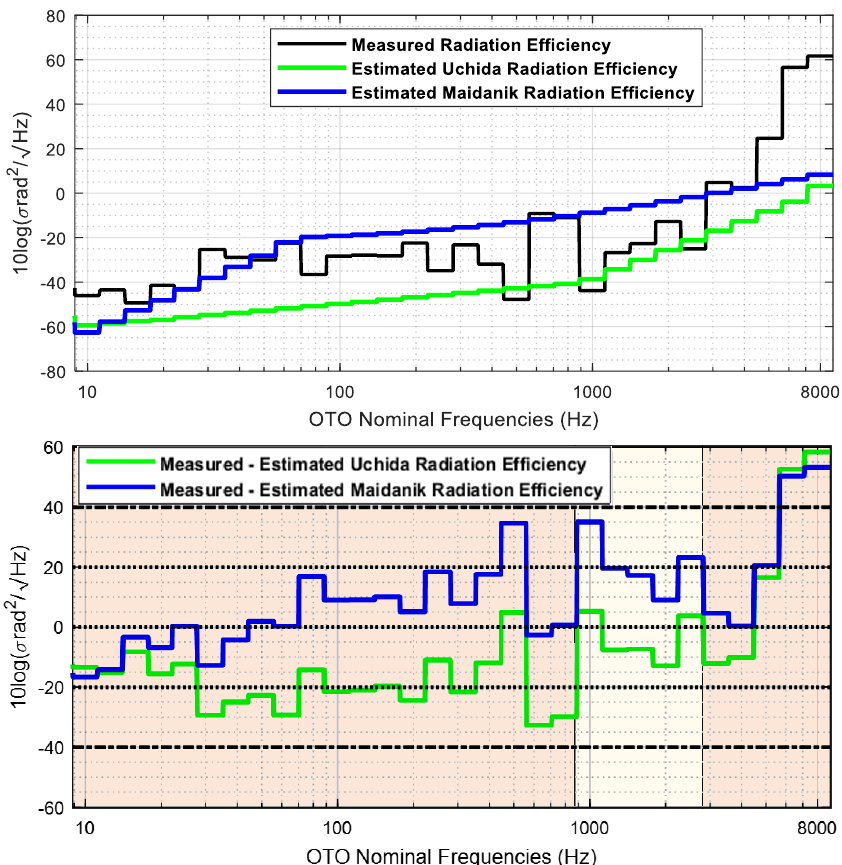
Figure 13. Measured and estimated radiation efficiency in broadband domain ( top ) and difference between the measured and estimated radiation efficiency using Uchida and Maidanik equations ( bottom ).